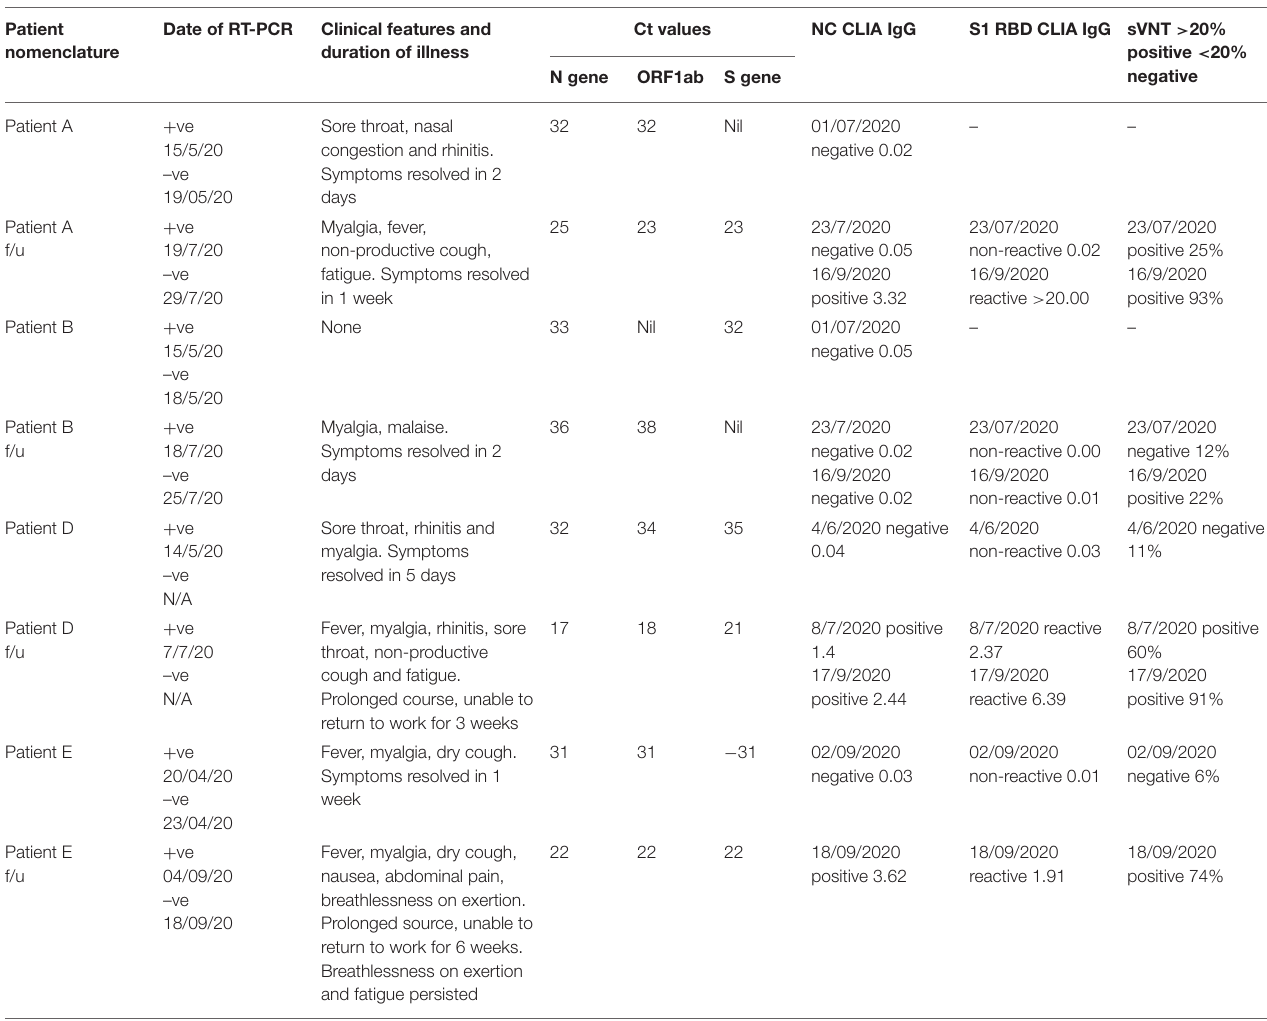
TABLE 1 | Clinical course, RT-PCR, and